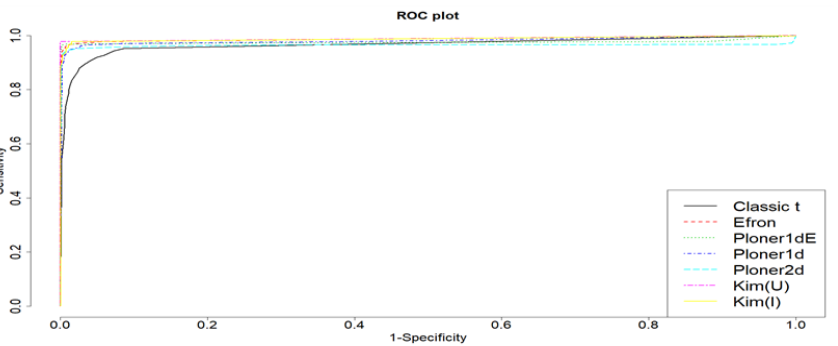
Figure 12. Scale change scenario and two-sided. ROC curve when k = 4 and cutoff values ranging from 0 to 1 with steps of 0.05.